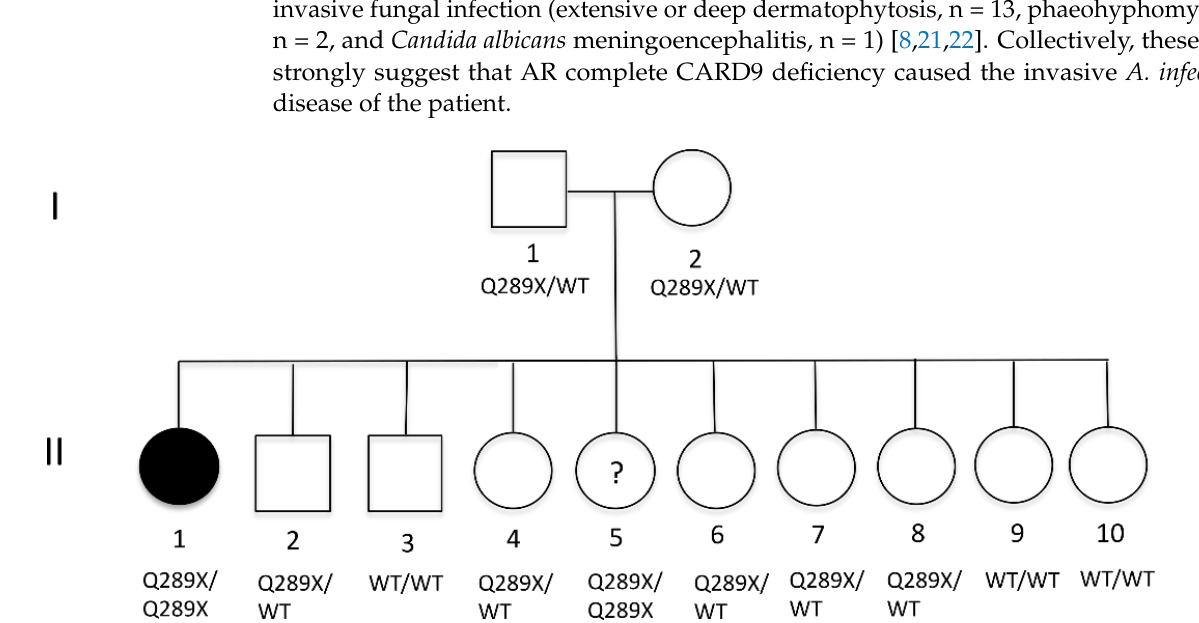
Figure 2. Mutation analyses in the kindred (I: parents, and II: siblings) of the reported patient (patient II.1). WT, wild-type.